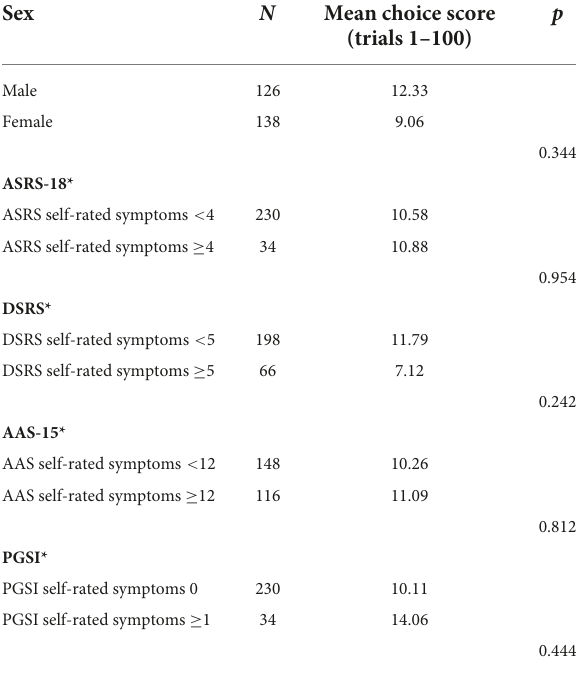
TABLE 2 Independent sample t -test analysis of mean choice scores across the task (trials 1–100) based on sex and self-reported